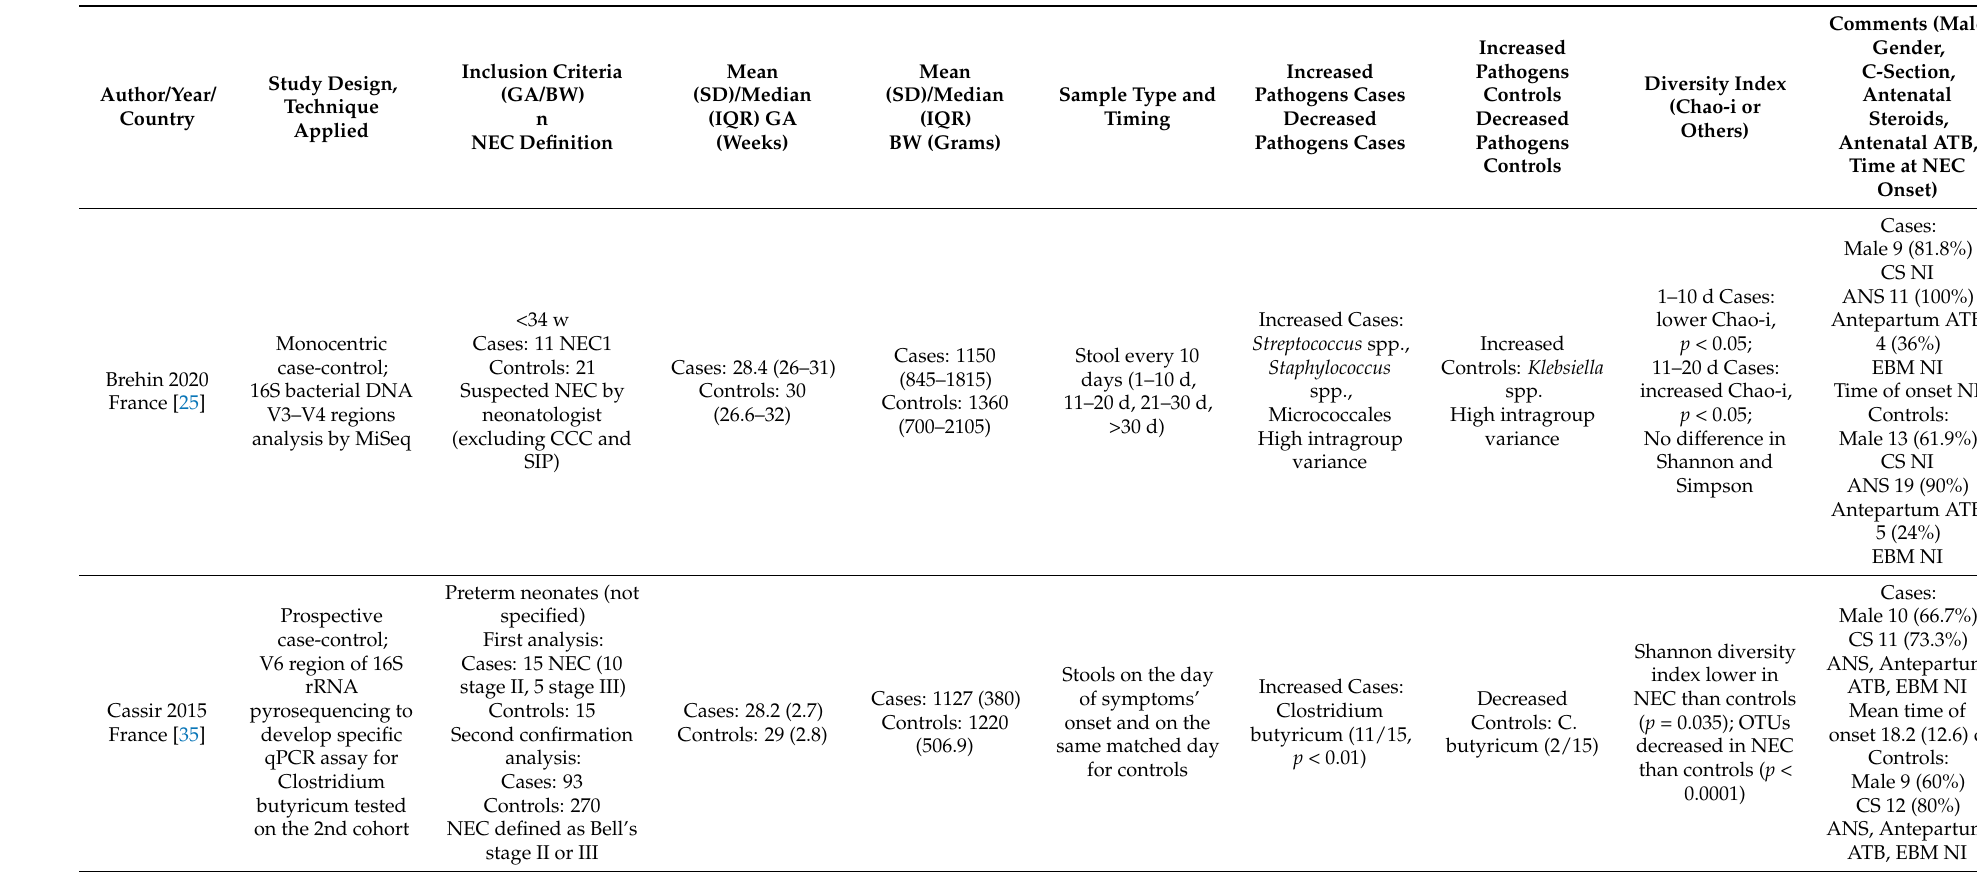
Table 2. Characteristics of studies applying untargeted gut microbiota analysis for the prediction/diagnosis of NEC/SIP (NEC/SIP prediction: early samples, first 14 days or >72 h from NEC onset; NEC diagnosis: late samples, <72 h from NEC onset) . In grey the studies defining NEC as Bell’s II or III and therefore included in the review. Numerical data are expressed as mean (SD) or median (IQR) or as number/percentage, if not otherwise specified. Not all pathogens reported in the seventh and eighth columns show a significant difference between cases and